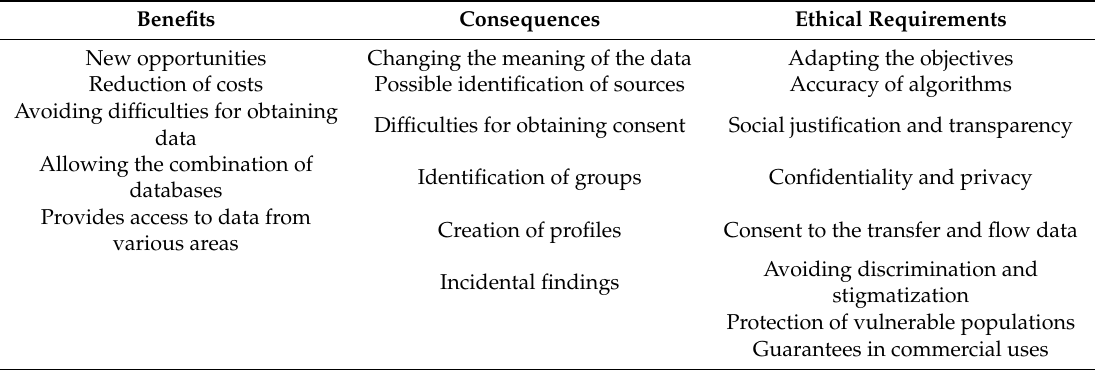
Table 2. Secondary uses of data 1